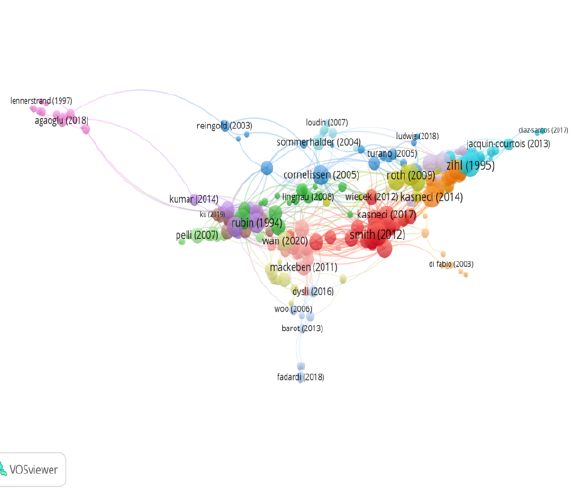
Figure 6. Citation network in Group